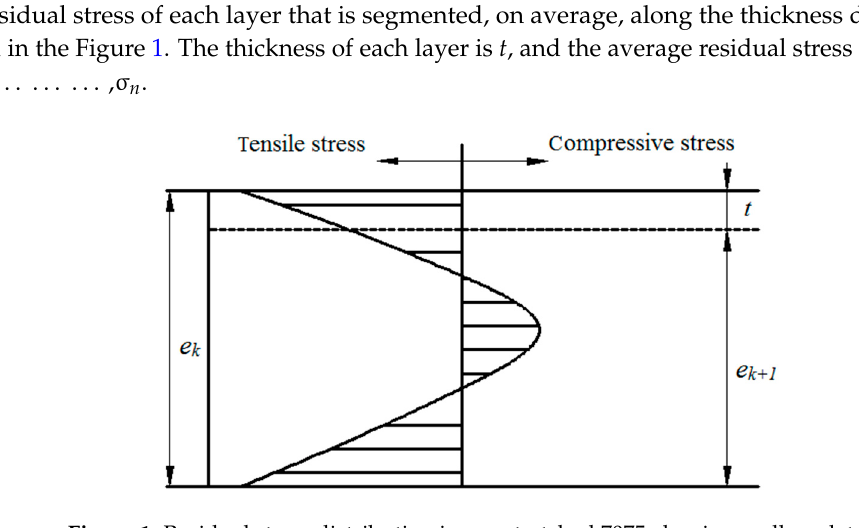
Figure 1. Residual stress distribution in pre-stretched 7075 aluminum alloy plate.